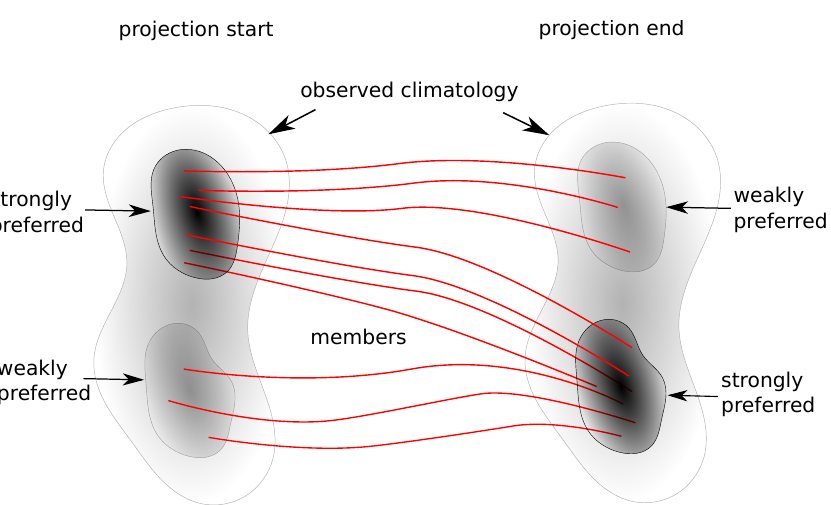
Figure 3. Internal response to forcing. The projection starts on the left with most of the projection members resident in a strongly preferred region of the climatology represented by the upper darker grey space. In response to forcing, the weakly preferred lower grey space (on the left) becomes the strongly preferred region, attracting more members, as shown by its darker shading on the